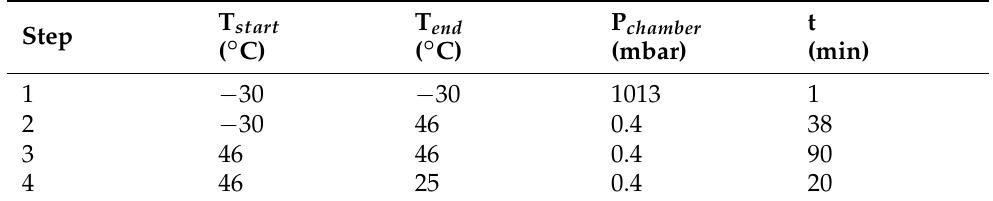
Table 1. Drying profile for single-layer drying to determine the freeze-drying kinetics of instant